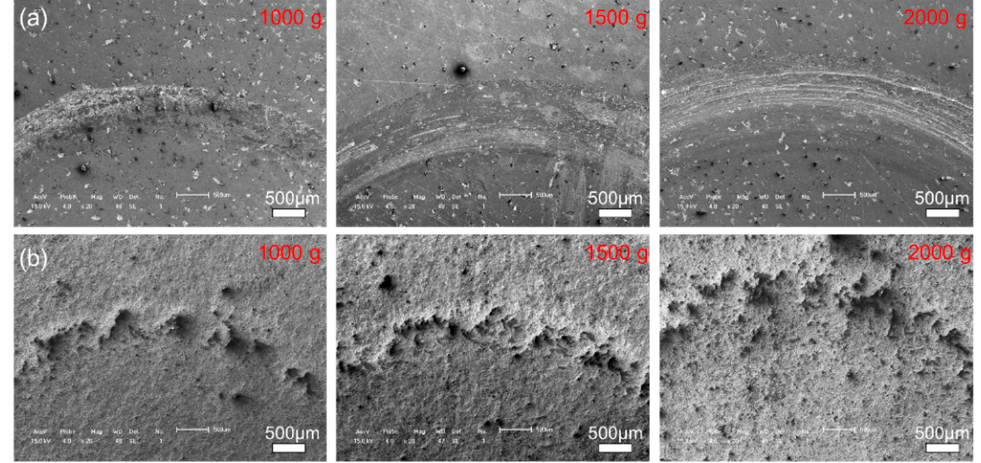
Figure 11. Typical SEM images of the wear track of the ( a ) 27CrMoV substrate and ( b ) WC–10Co4Cr coatings after friction test at different loads.